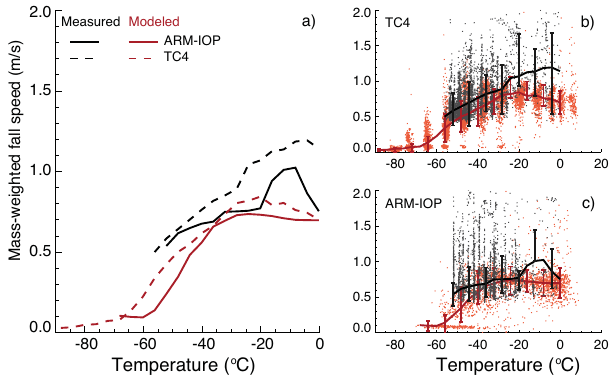
Figure 7. Mass-weighted terminal fall speed. (a) Measured and modeled V m for ARM-IOP and TC4 for comparing fall speeds be- tween campaigns. (b) and (c) Mass weighted fall speeds for show- ing the measurement and modeling spread.